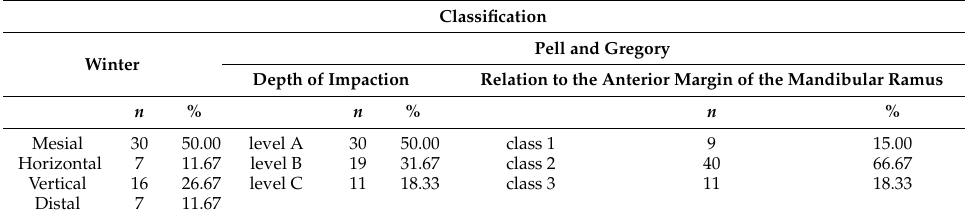
Table 2. Characteristics of the position of lower wisdom teeth.